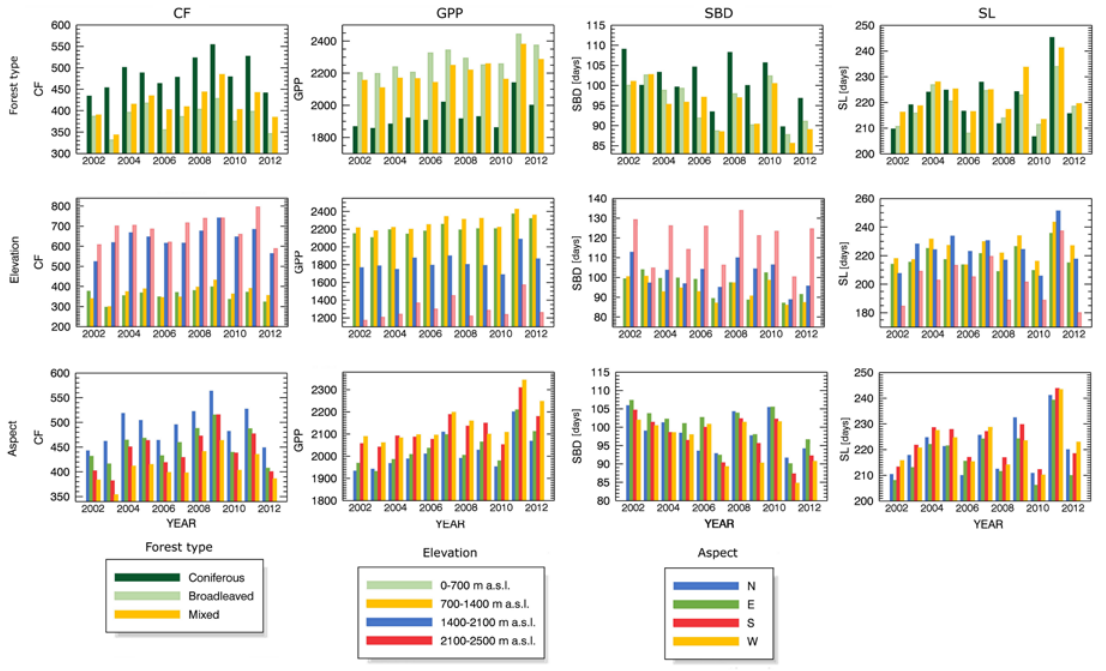
Figure 8. Marginal means plots of repeated ANOVA showing CF, GPP, SBD and SL variability (in columns) in relation to forest type, elevation and aspect (in rows). Analyses performed for the 3nNDVI drought impact class 1 spatial footprint. Categories plotted in transparent comprise less than 50 observations. Abbreviations are explained in Figure 3.